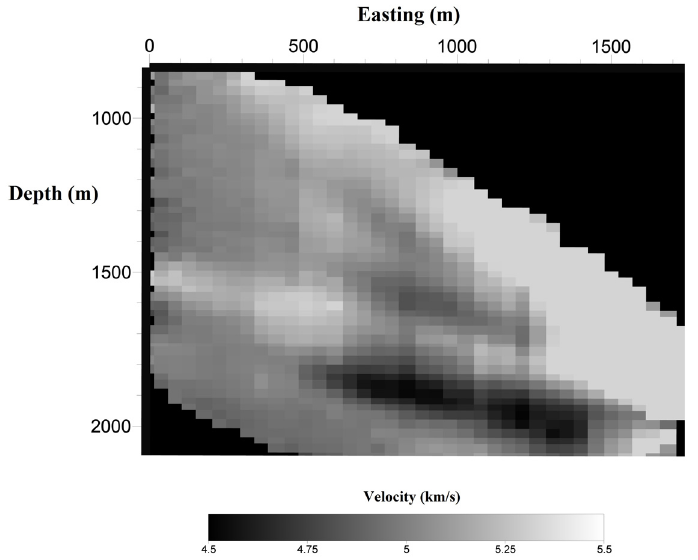
Figure 10. Tomogram showing the checkerboard velocity model using the events and receivers from the first time period at a northing slice of − 290